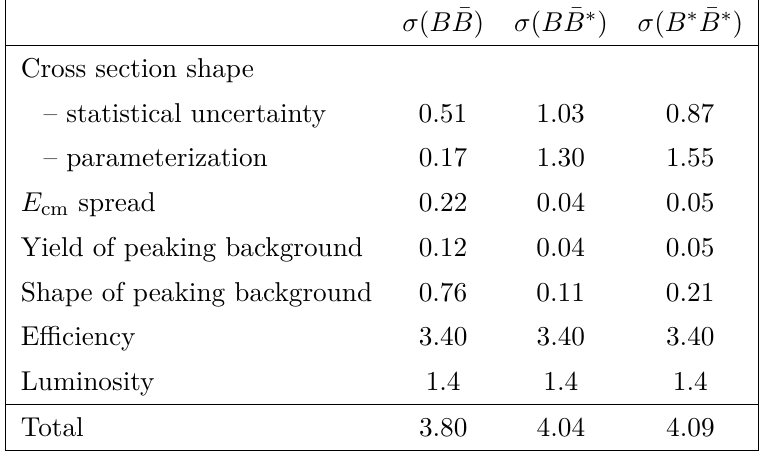
Table 6 . Correlated systematic uncertainties in cross sections at Υ(5 S ) (in